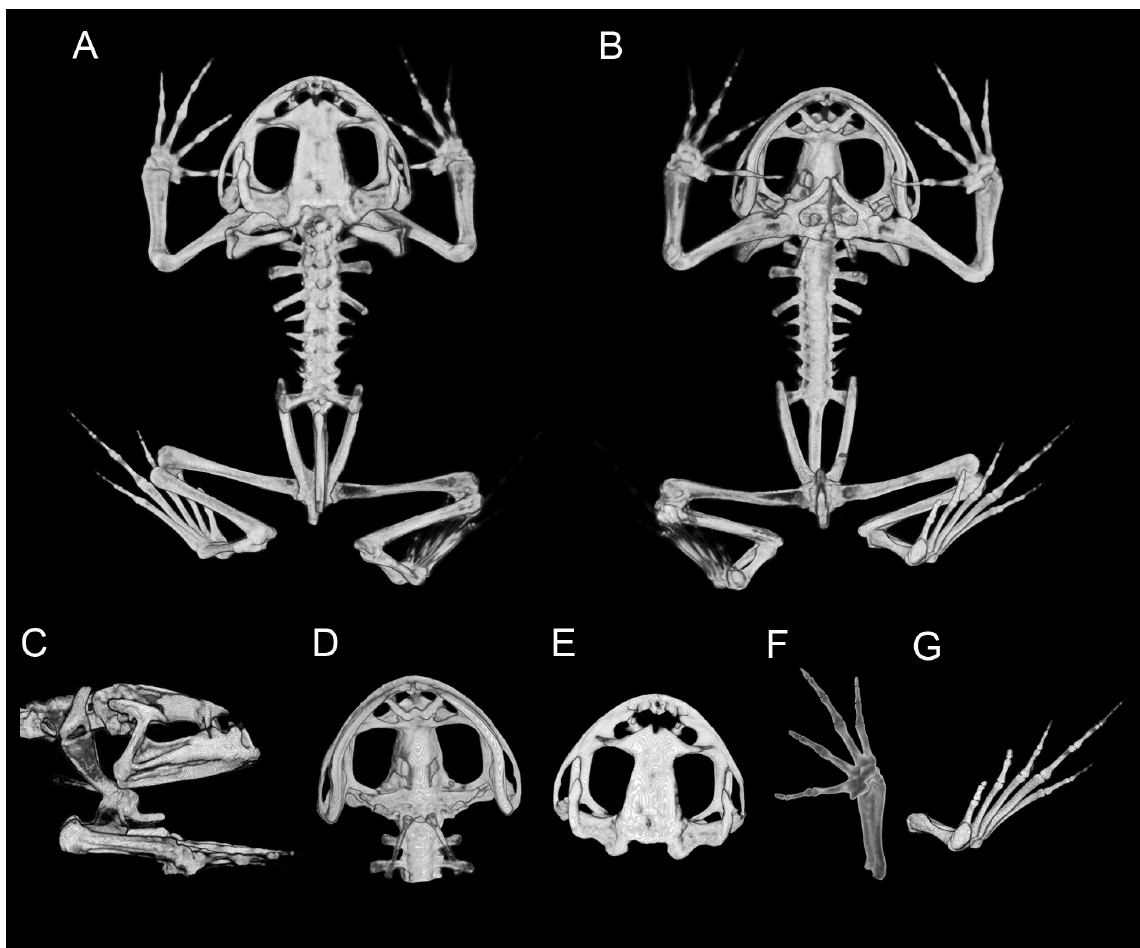
Fig. 5. Odontophrynus toledoi sp. nov., holotype, ♂ (ZUEC-AMP 24833), skeleton, generated by microtomography. A . Dorsal view of the individual. B . Ventral view of the individual. C . Lateral view of the head and arms. D . Ventral view of the skull. E . Dorsal view of the skull. F . Ventral view of the hand. G . Ventral view of the foot.